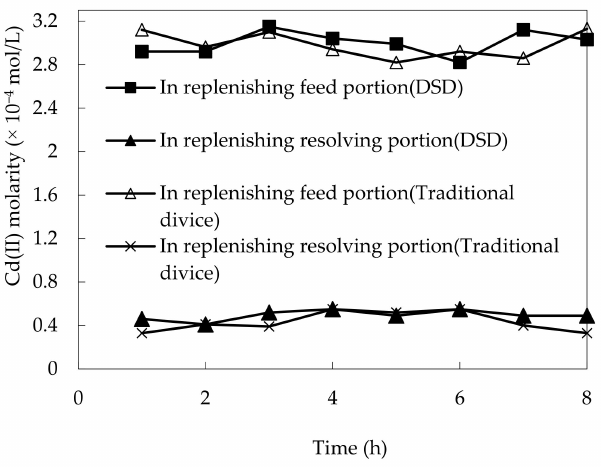
Figure 4. The constancy of DSD.